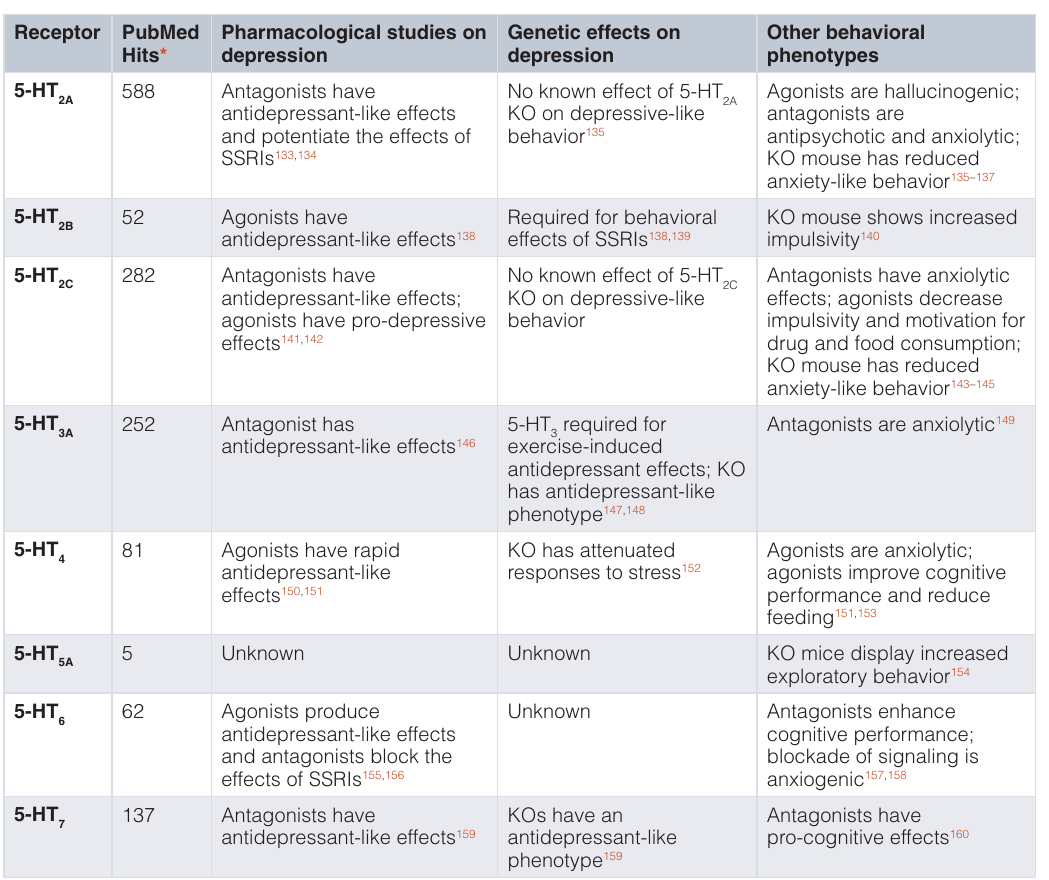
Table 1. Preclinical evidence supporting the role for serotonin receptors in